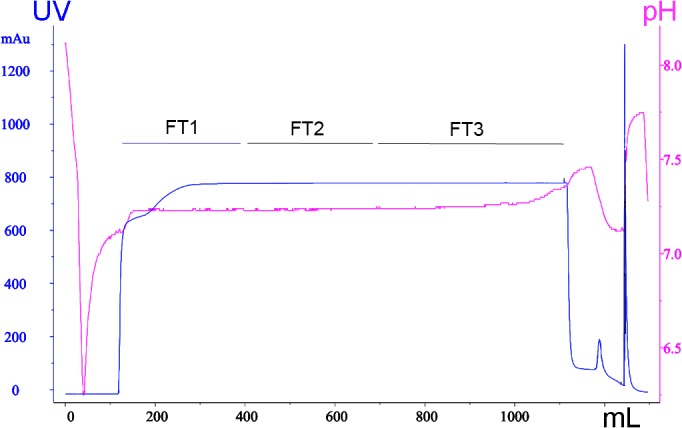
Chromatographic profile at 280 nm obtained when filtering DMEM medium supplemented with 10% FBS on the QSD device.The y-axis represents the absorbance at 280 nm (red line) and the y2 axis the pH value (blue line). The x-axis is the volume (mL) of growth medium passed through the QSD device. FT: flow-through. AU: absorbance unit